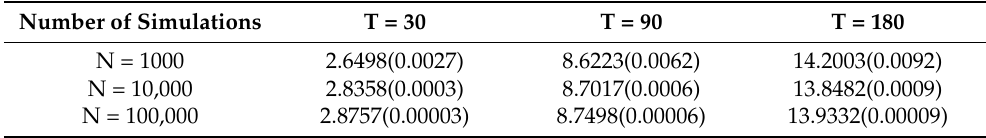
Table 3. Price of arithmetic average Asian options (fixed-strike call option). The values in brackets denote the standard error of the MC simulation